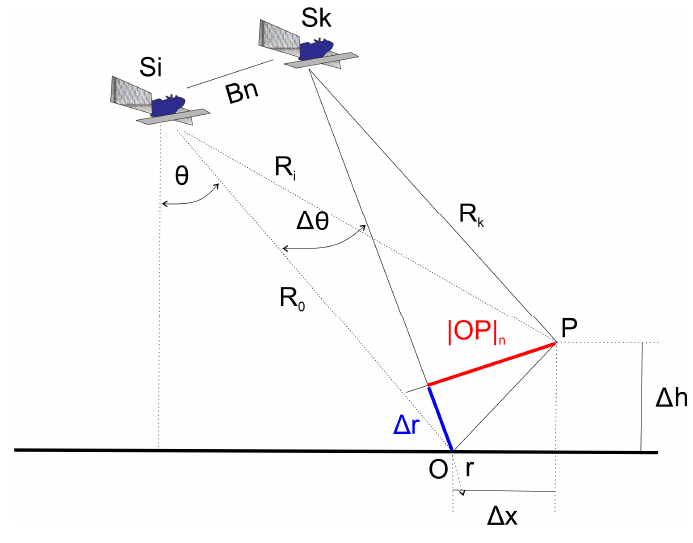
Figure 3. Acquisition geometry for interferogram generation.